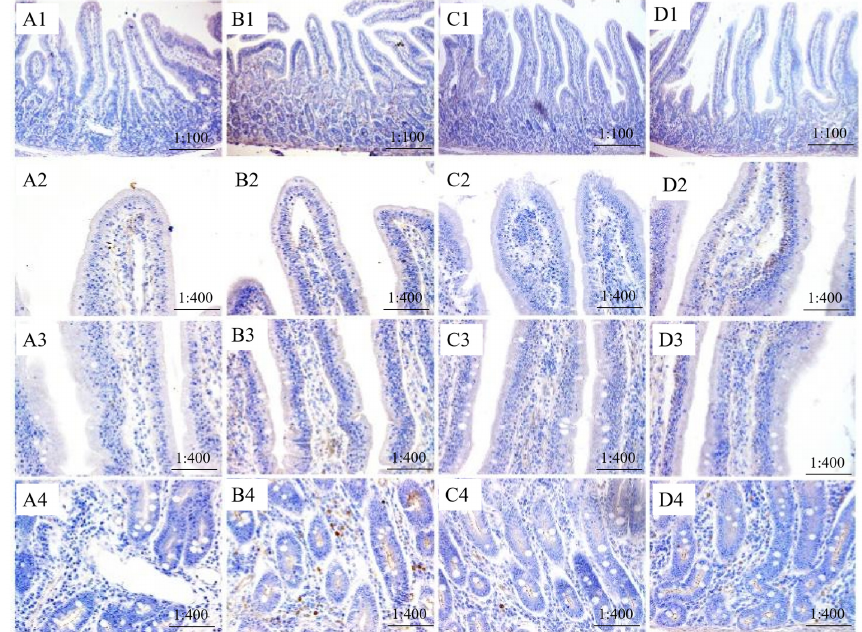
Figure 3. Effect of probiotics with added glucose oxidase (PGO) and Illicium verum extracts (IVE) on the immune positive distribution of Zona Occludens 1 (ZO-1) in jejunum of weaned piglets. Treat- ment 1 was fed with basal diet (IVE-PGO−, ( A1 – A4 )), and treatments 2, 3, and 4 were fed the basal diet supplemented with 1000 mg/kg PGO (IVE-PGO+, ( B1 – B4 )), 500 mg/kg IVE (IVE + PGO−, ( C1 – C4 )), and 500 mg/kg IVE + 1000 mg/kg PGO (IVE + PGO+, ( D1 – D4 )), respectively. The mRNA expression of ZO-1 and SGLT1 in jejunum of weaned piglets increased by adding IVE and PGO alone (Table 6, p < 0.05). In addition, PGO can also increase the mRNA expression of occludin and CAT1 ( p < 0.05). The combination of IVE and PGO had significant interaction on increasing the mRNA expression of ZO-1 and SGLT1 in the je- junum ( p < 0.05) and also showed a trend of promoting the mRNA expression of CAT1 ( p < 0.10). Table 6. Effect of probiotics with added glucose oxidase (PGO) and Illicium verum extracts (IVE) on the relative mRNA expression of jejunum in weaned piglets 1 . Items